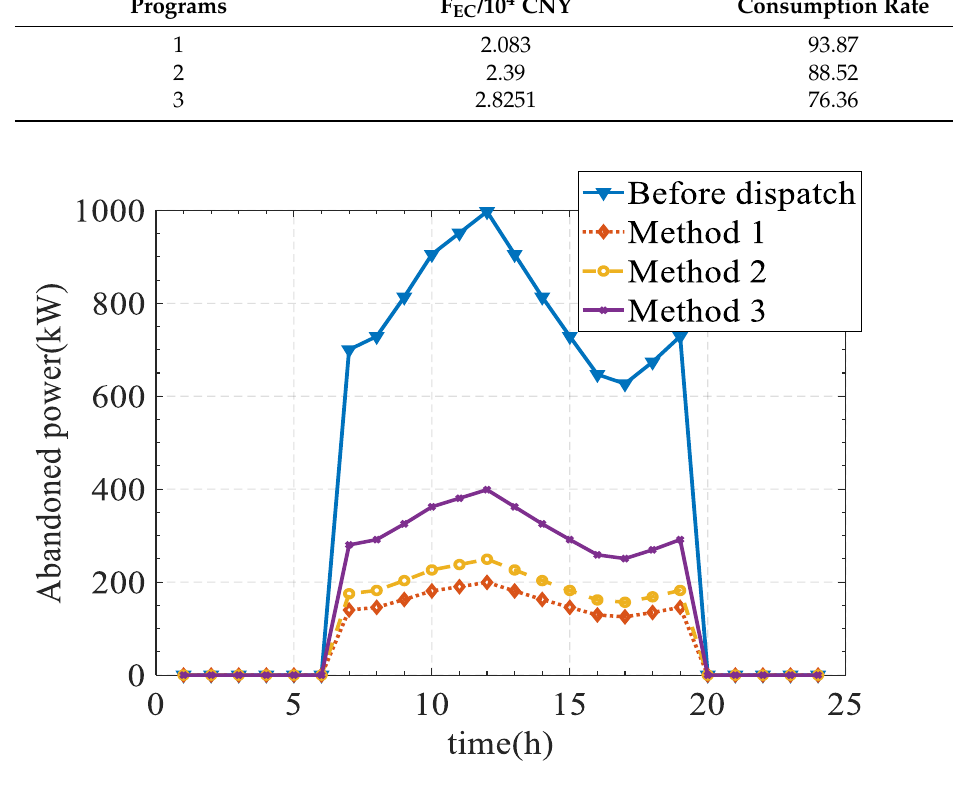
Figure 7. Abandoned